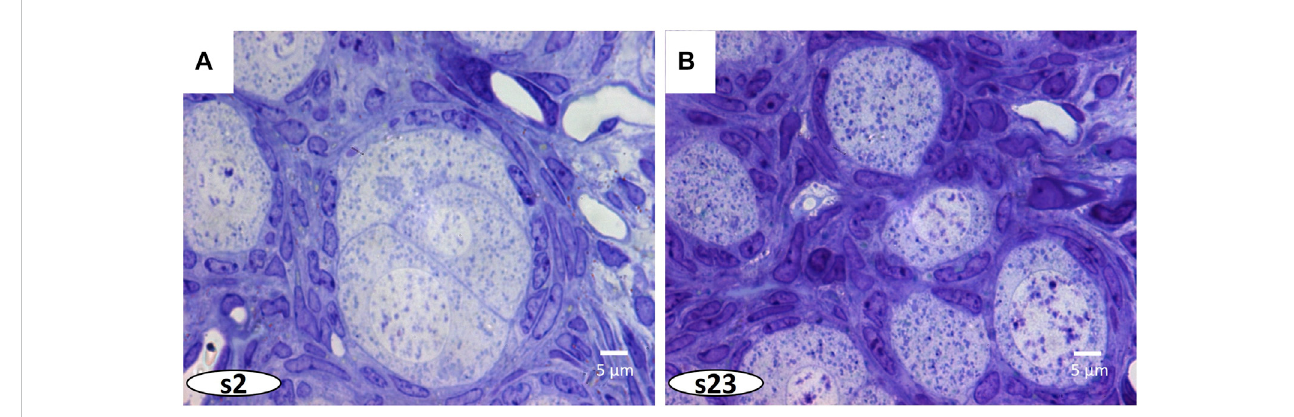
FIGURE 4 In Figure 3, a greater magni fi cation of the ovarian cyst is indicated by a dashed white square. (A, B) The 3D reconstruction of this cyst shows close association between oocytes and surrounding pre-follicular cells.